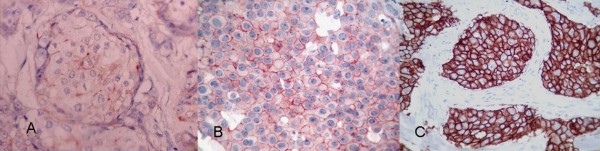
Microscopy pictures illustrating the patterns of HER-2 immunostaining in breast carcinoma. (a) Weak positive (1+) pattern exemplified by weak focal membrane staining seen in more than 10% of the tumor cells. (b) Intermediate (2+) pattern, showing weak to moderate complete membrane staining in more than 10% of the tumor cells. (c) Strongly positive (3+) pattern shows intense membrane staining with weak cytoplasmic reactivity in more than 30% of the tumor cells.